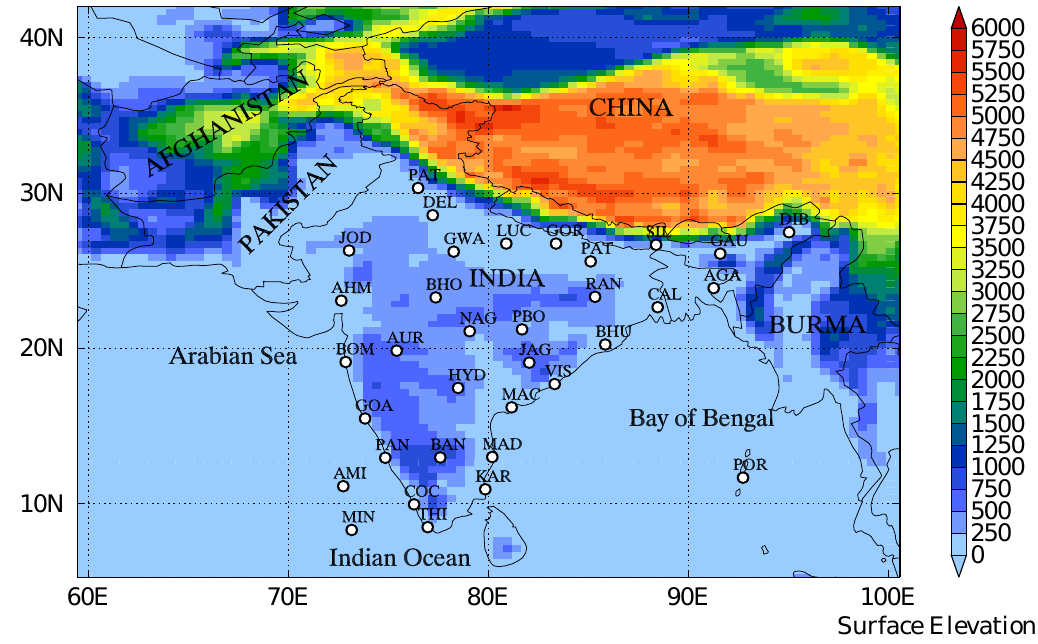
Fig. 1. The simulation domain and the topography used by the model. The geographic locations of RAOB sites used in this study are also shown. The description of station codes is provided in Table